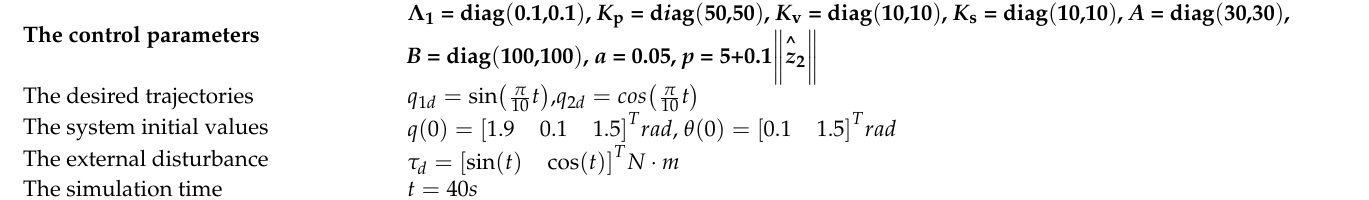
Table 2. The parameters of the control.